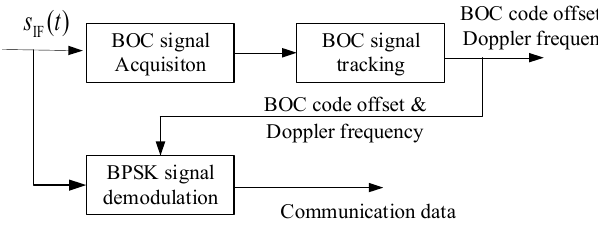
Figure 3. The reception of composite